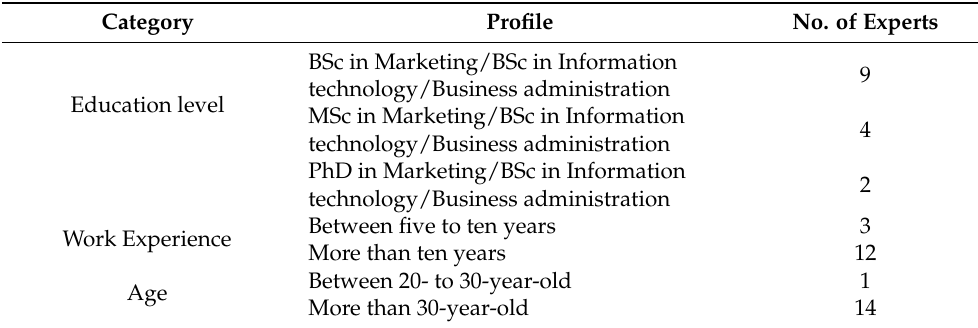
Table 3. Initial comparison matrices .